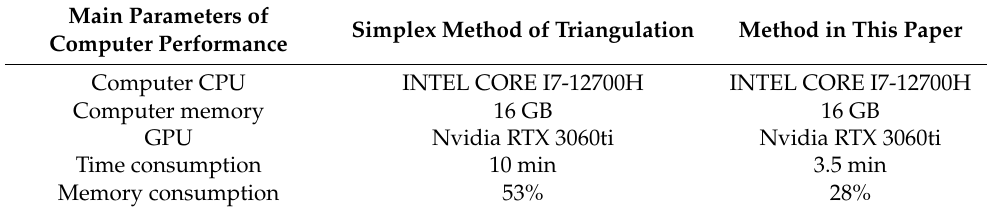
Table 1. Comparison of the two methods for test data of 500 m × 500